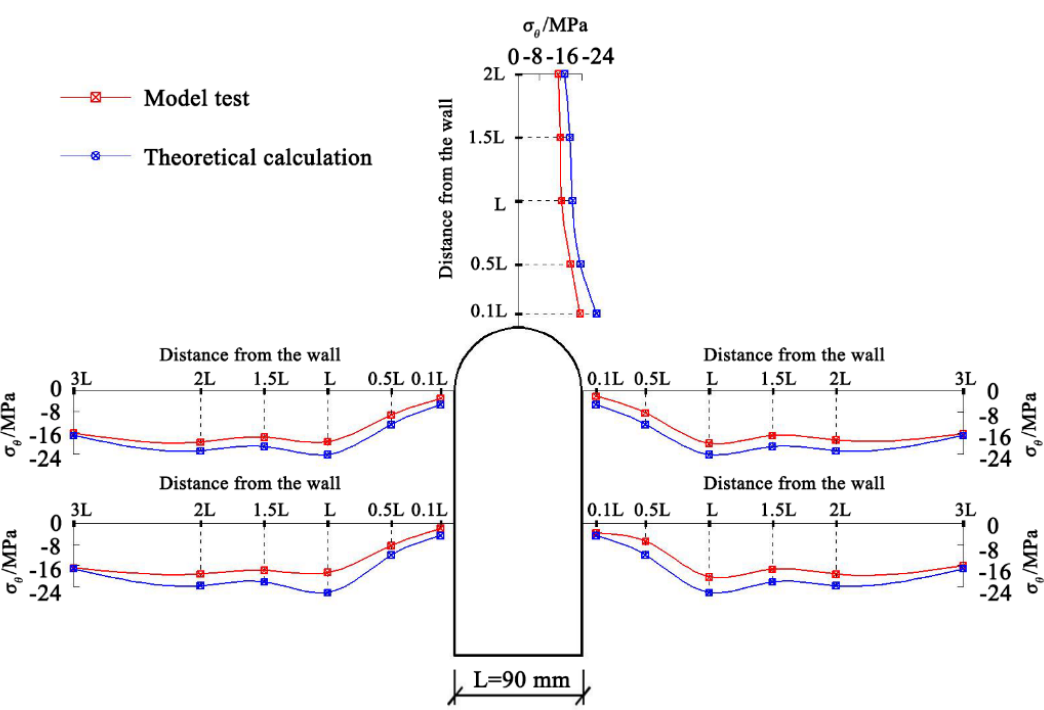
Figure 12. Variation of the tangential stress around the cavern. 511 Table 5. Tangential stress around the cavern.